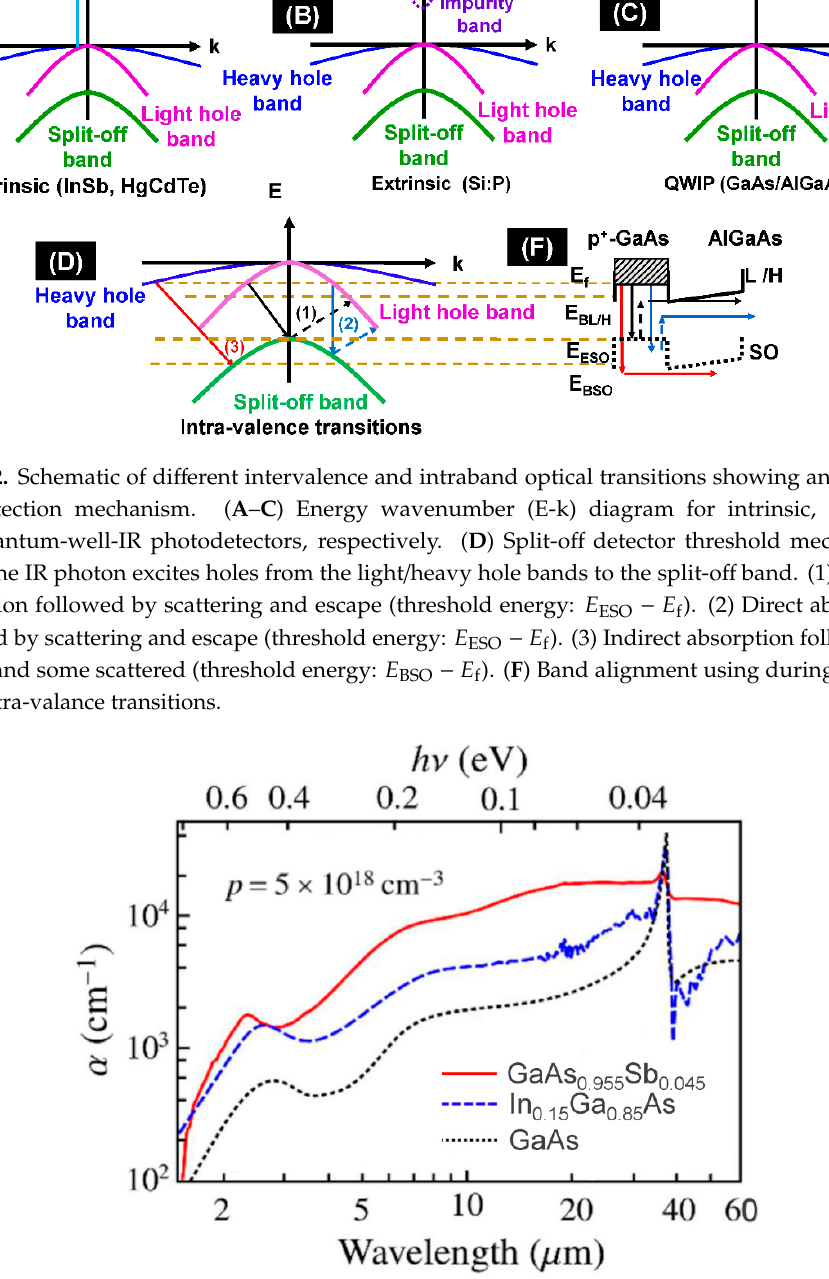
Figure 3. Absorption coefficient of p-type (5 × 10 18 cm − 3 ) GaAs 0.955 Sb 0.045 , In 0.15 Ga 0.85 As and GaAs as discussed [69]. The p-type GaAs 0.955 Sb 0.045 shows the highest absorption coefficient by comparing with the other two materials.